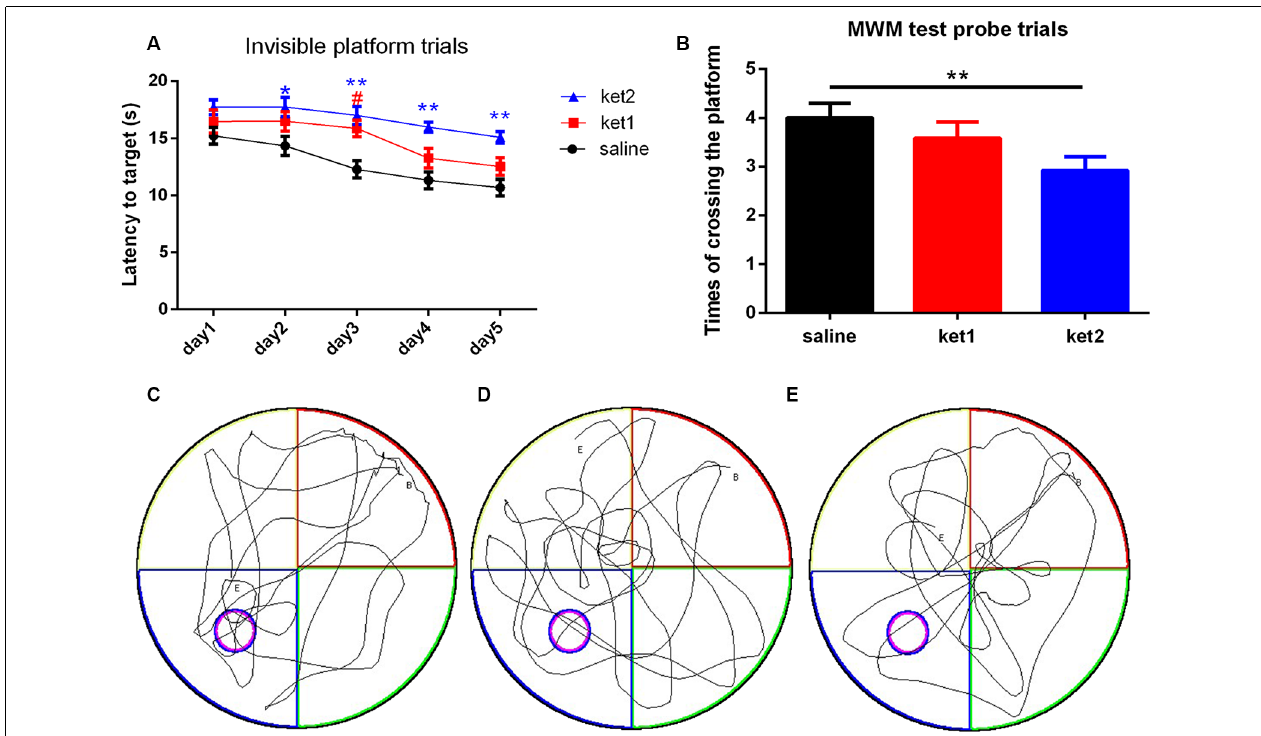
FIGURE 2 | Spatial memory performance of mice in the MWM test following 6 months of ketamine administration with different doses of ketamine 30 mg/kg and 60 mg/kg. (A) Repeated measures 2-way ANOVA was used in the analysis of latency time in probe trials. Main effect of treatment (saline, Ket1, Ket2), time)day1-day5) and interactions of treatment × time are reported as followed: treatment F (4,52) = 6.32, ** p < 0.01; time F (2,26) = 6.919, ** p < 0.01; interactions of treatment × time F (8,104) = 0.758, p = 0.8475. Significant increase of latency time to reach the target in MWM test invisible platform trails in ket2 group in the training day 2, 3, 4, 5 after 6 months of administration paradigm (* p < 0.05, ** p < 0.01) and ket1 group saw an increase of latency time to reach the target only in the training day 3 ( # p < 0.05). (B) A significant decline of the times of crossing the former platform location was observed in the ket2 group comparing with the control group ( F (2,39) = 5.474, ** p < 0.01). (C–E) Representative swimming paths by mice with different treatments in probe trial tests (saline n = 14, ket1 n = 14, ket2 n =